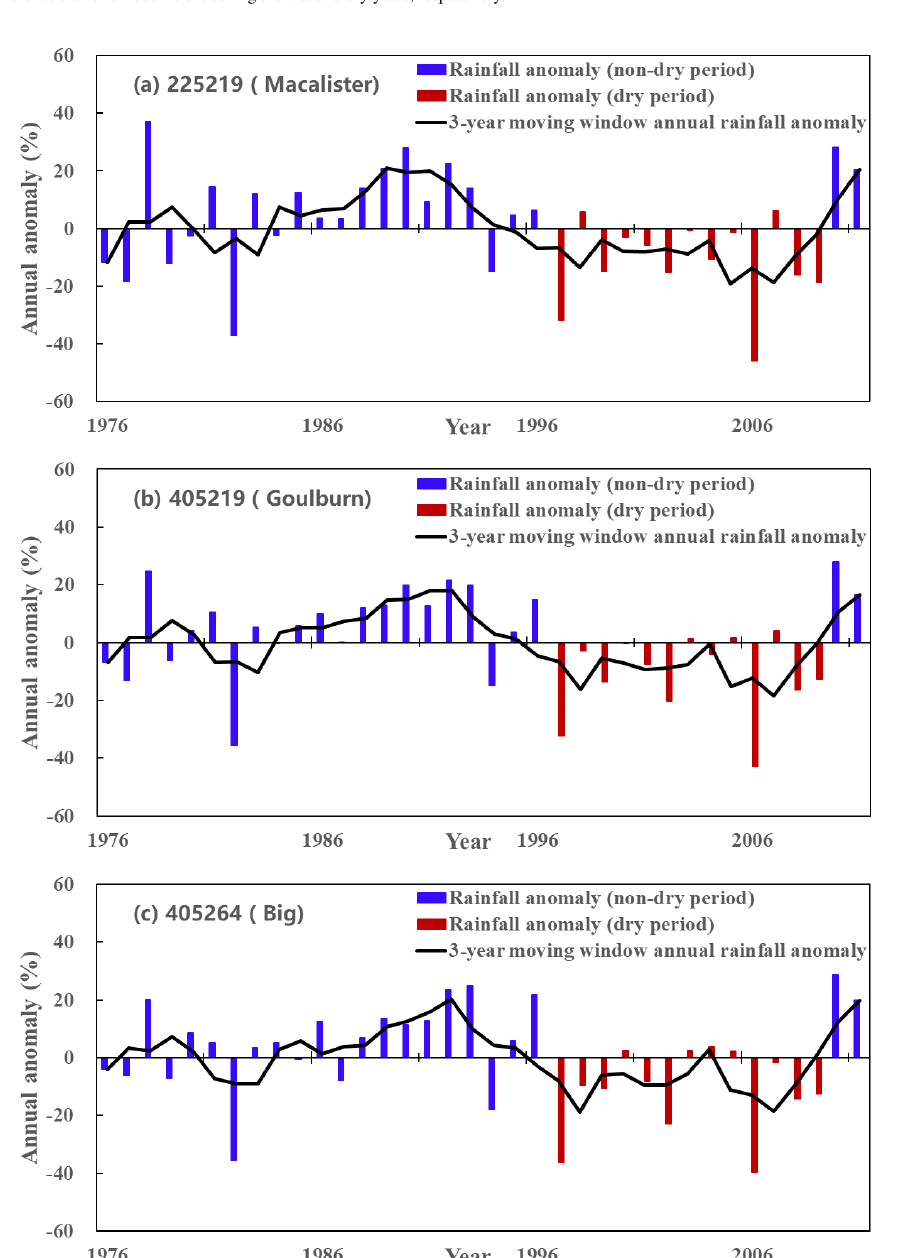
Figure 4. The identified dry years in all catchments. The annual anomaly is defined as a percentage of the mean annual rainfall.